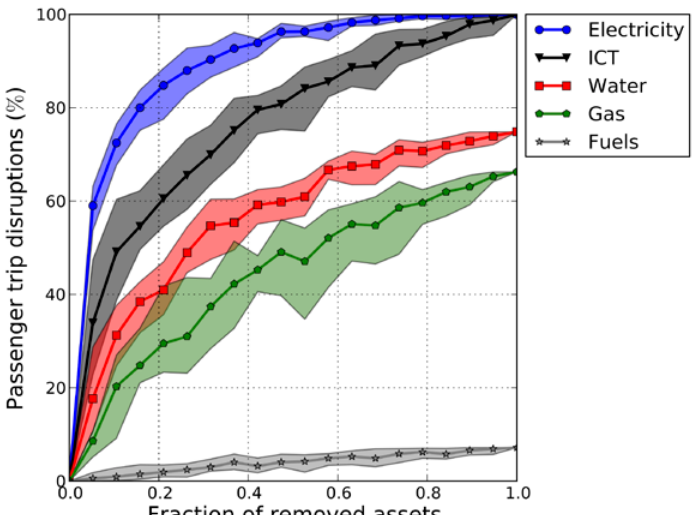
Figure 8. Vulnerability of the railway network due to failures induced through other infrastructures.